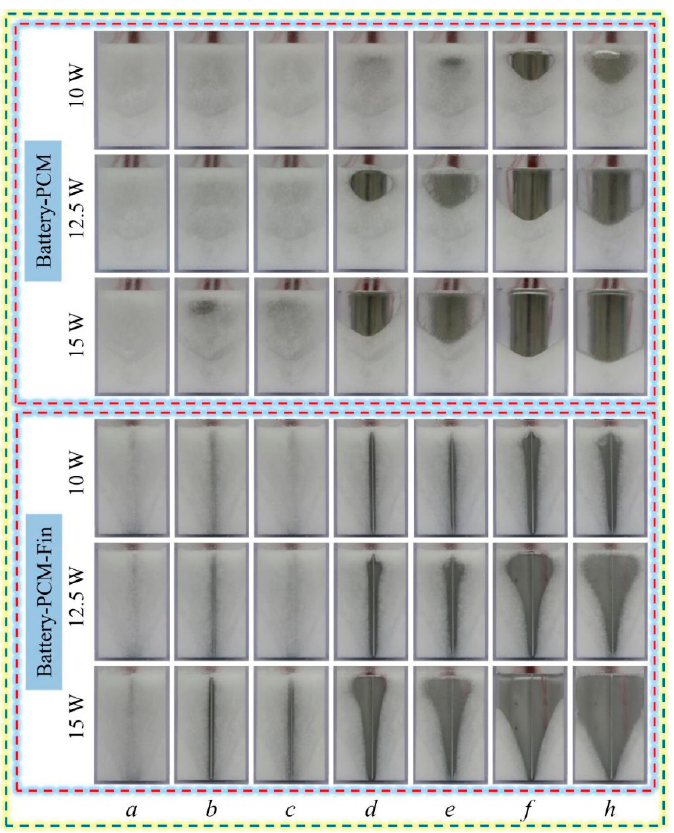
Figure 10. Visualization of the phase transition process during thermal cycling [54] (images a to h were taken at the beginning/end of each of the six segments in Figure 9). Reproduced with permission from Elsevier.